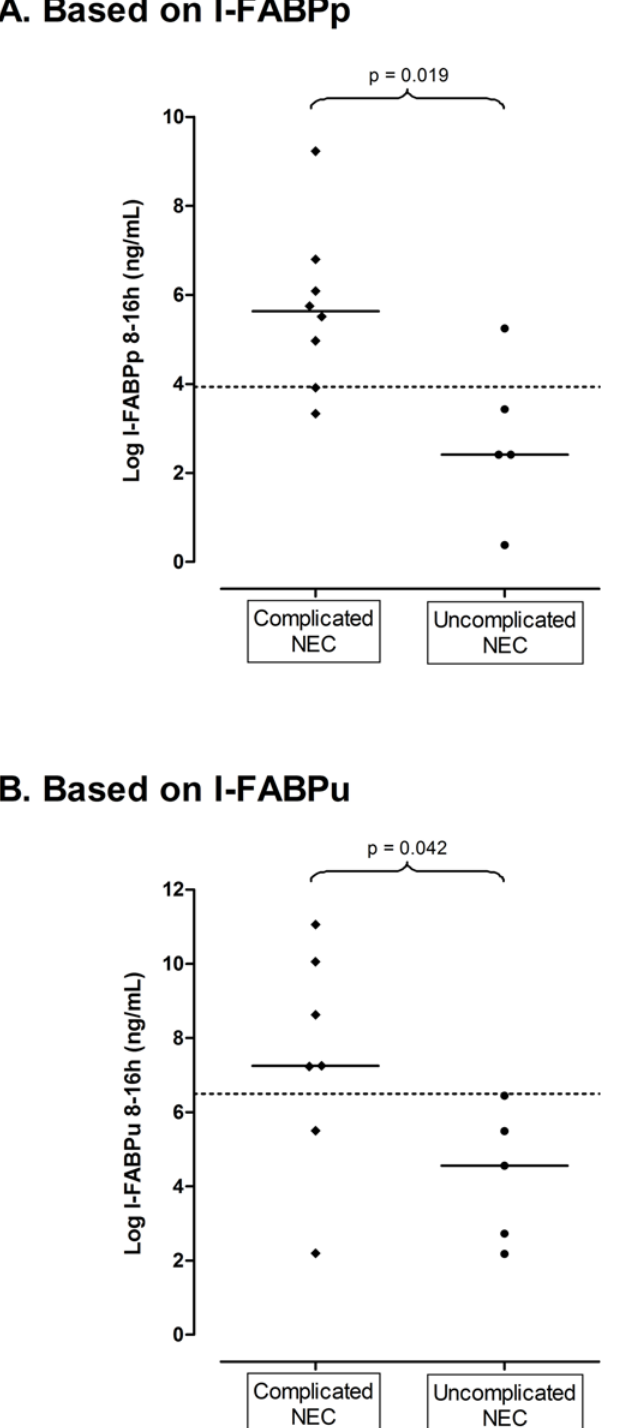
Fig 4. Median I-FABP values (after logarithmic transformation), measured in plasma (A) and urine (B) from 8 – 16 h, of patients with complicated NEC (n = 11) versus uncomplicated NEC (n = 11). Cut-off points to differentiate between groups are represented by dotted lines (after logarithmic transformation: cut- off points at 3.9 and 6.5 ng/mL correspond to cut-off points at 19 and 232 ng/mL, as mentioned in tables 4A and 4B, respectively). A. Based on I-FABPp. B. Based on